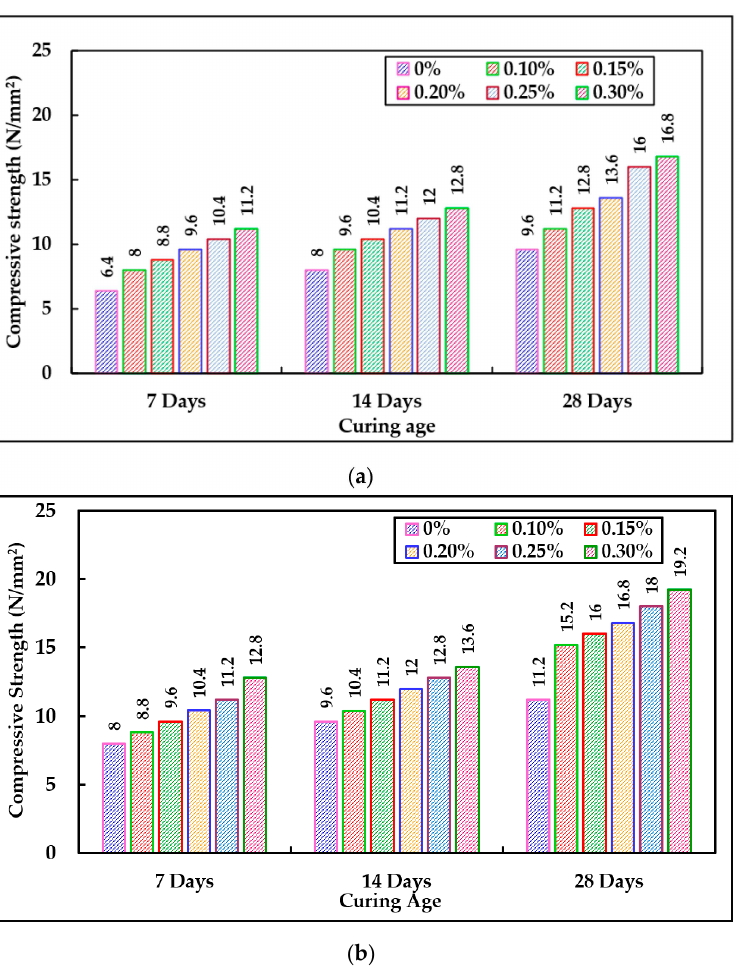
Figure 7. Graphical illustration of mortar cube compressive strength with brass fibres added. ( a ) Air curing; ( b ) Water curing.